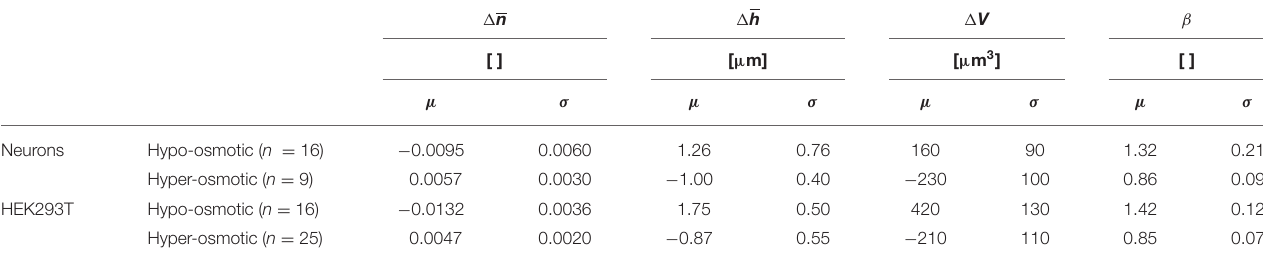
TABLE 2 | Measured variations of biophysical parameters induced by osmotic challenges on populations of primary neurons and HEK293T cells. 1 n 1 h 1